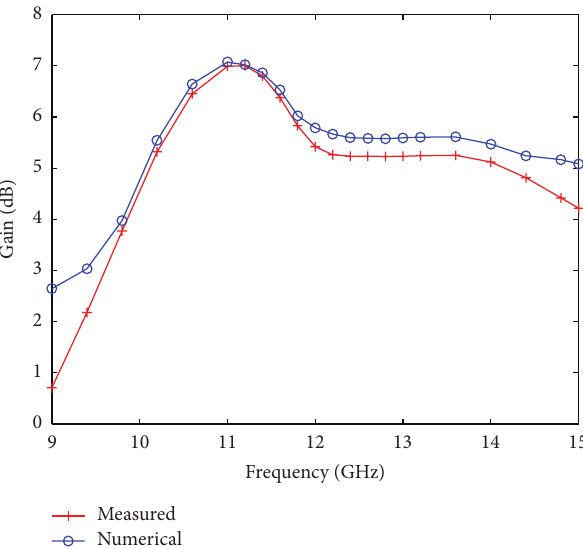
Figure 4: Return loss versus frequency plot of calculated and measured results of proposed antenna.